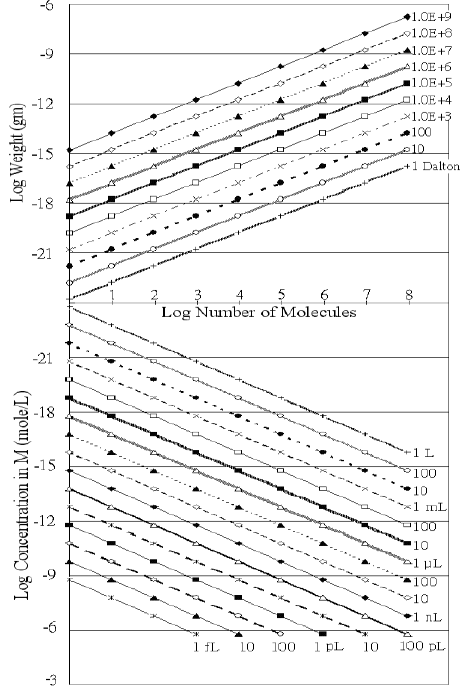
Figure A-1. Two sets of graphs relating the number of analyte molecules to the sample volume and concentration (bottom) and to the molecular and total weights